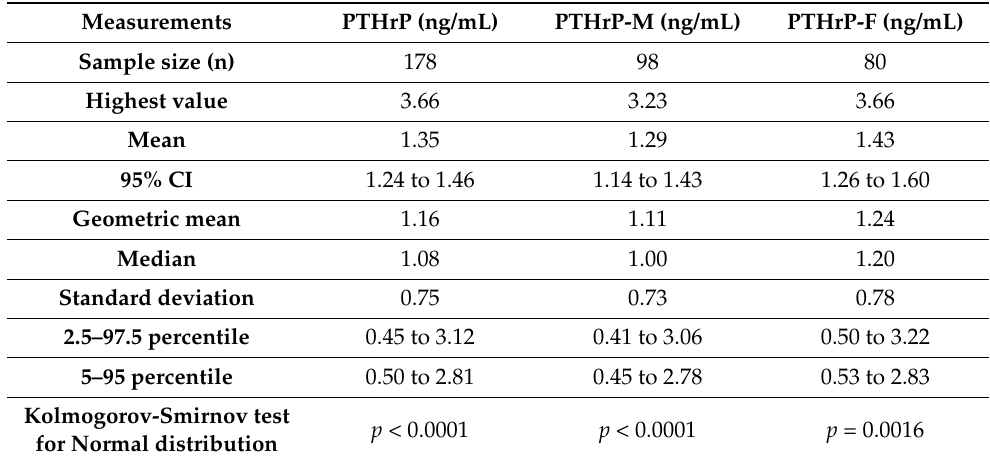
Table 1. Summary statistics of PTHrP values in all subjects and after stratification by sex (male: PTHRP-M; female